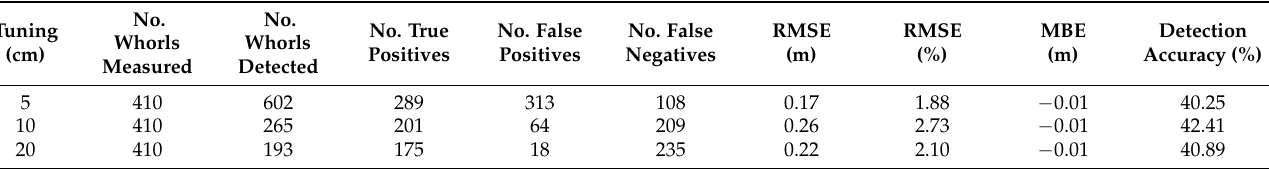
Table 4. Results for whorl detection along with values for precision and bias for each of the three configurations of the detection